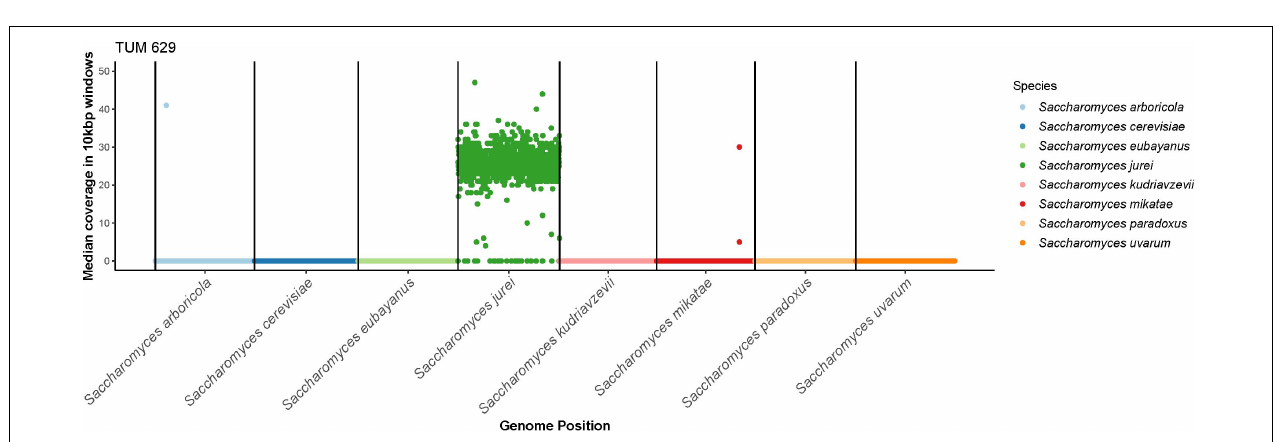
FIGURE 2 | The median coverage in 10 kbp windows of sequencing reads from S. jurei TUM 629 aligned to a concatenated reference genome consisting of 8 species in the Saccharomyces genus. Reads align exclusively to S. jurei, except for two small regions in the sub-telomeric regions of S. arboricola chromosome 4 and S. mikatae chromosome 14. Results were visualized in R using modified scripts from sppIDer (Langdon et al., 2018).